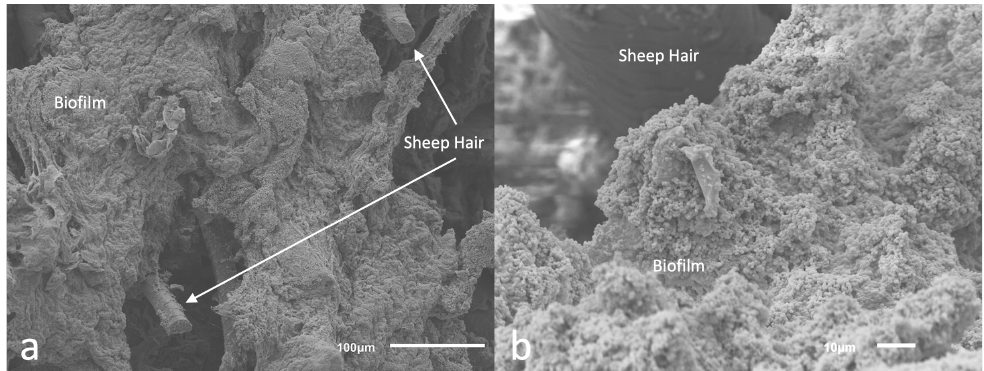
Figure 8. Skin inoculated with biofilm. ( a ): Zoomed out image where sheep hair can be observed on the surface of the skin inoculated with biofilms ( b ) Closer look at the cells composing the biofilm inoculated onto the sheep